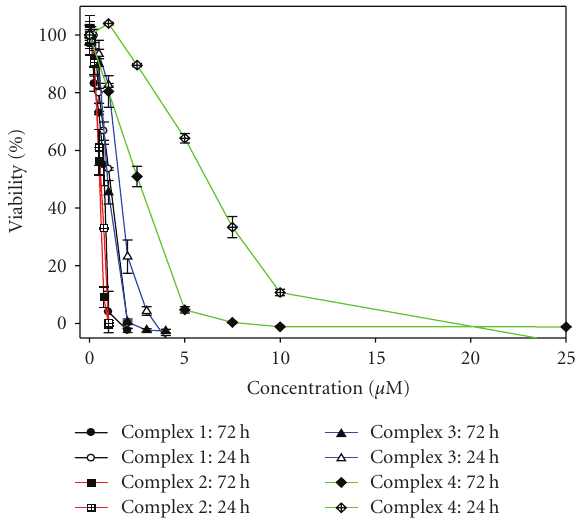
Figure 8: Inhibitory e ff ects of complexes 1 , 2 , 3 and 4 on tumor cell proliferation in